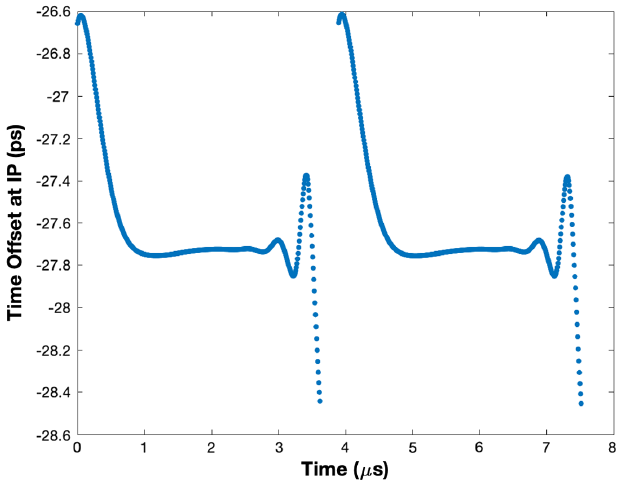
FIG. 8. IP time offset with one-turn